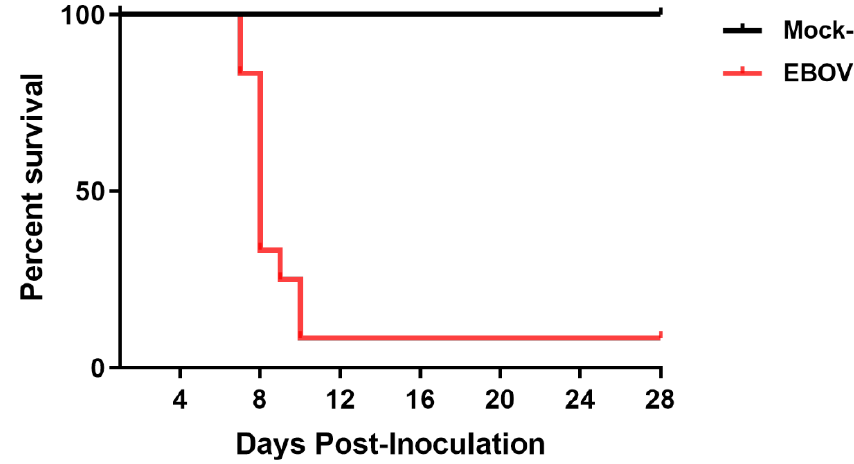
Figure 1. Kaplan–Meier plot of survival of EBOV-exposed and mock-exposed rhesus macaques.